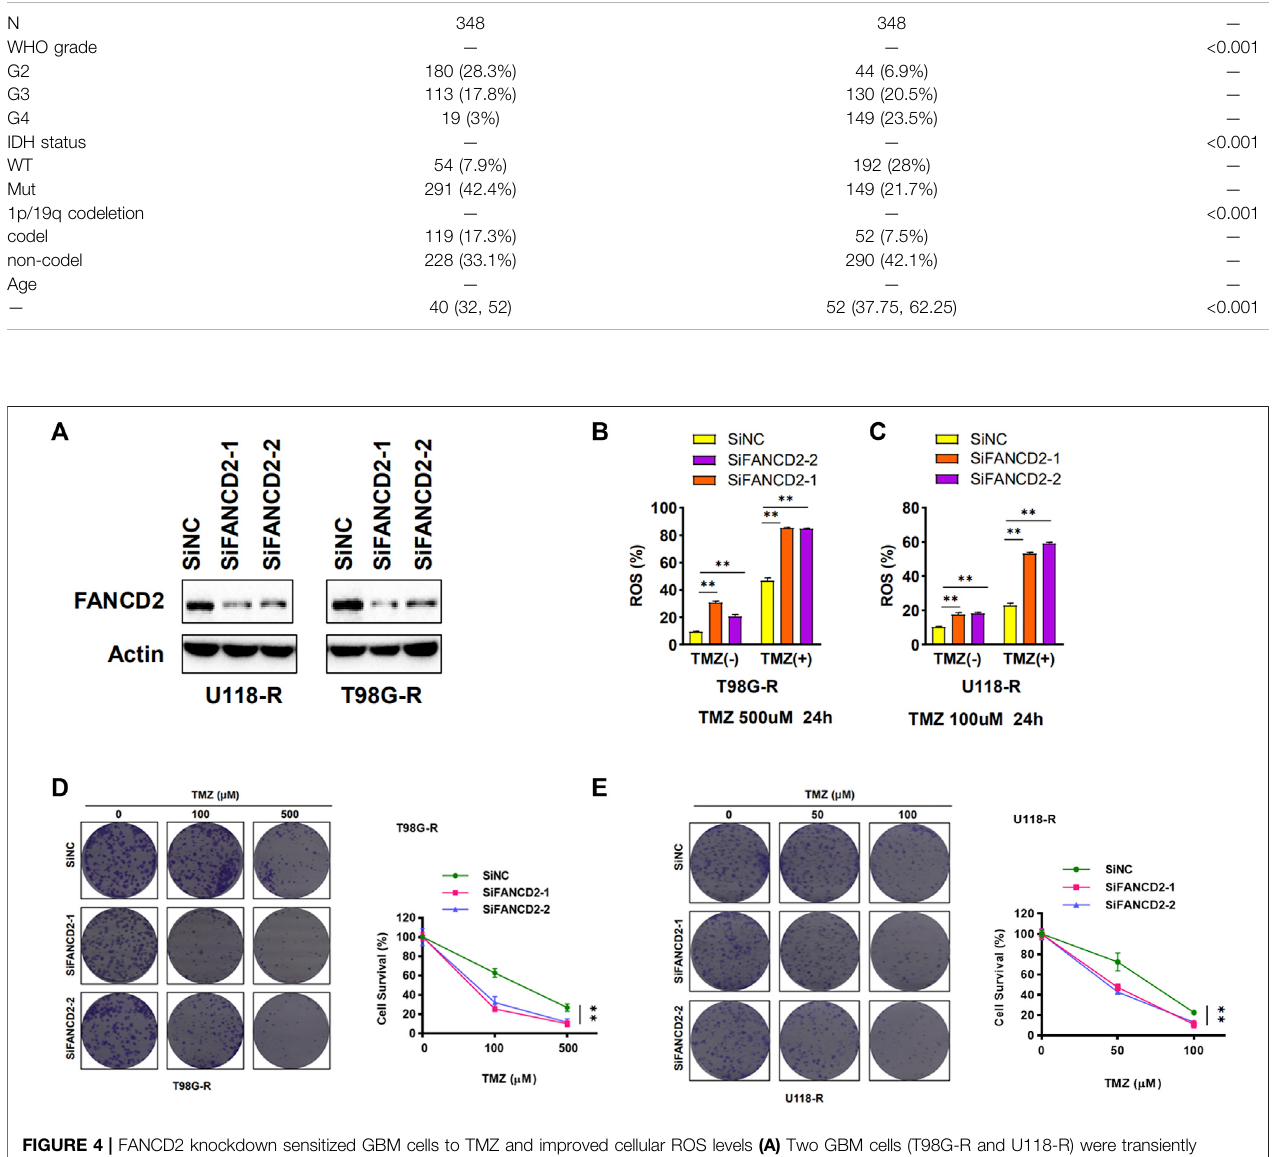
FIGURE 4 | FANCD2 knockdown sensitized GBM cells to TMZ and improved cellular ROS levels (A) Two GBM cells (T98G-R and U118-R) were transiently transfected with the FANCD2 siRNA. Cell lysates were then blotted with the indicated antibodies (B – C) Cellular ROS levels were up-regulated in FANCD2 knockdown cells (D – E) FANCD2 knockdown signi fi cantly inhibited the cell survival induced by the TMZ treatment. ** p <